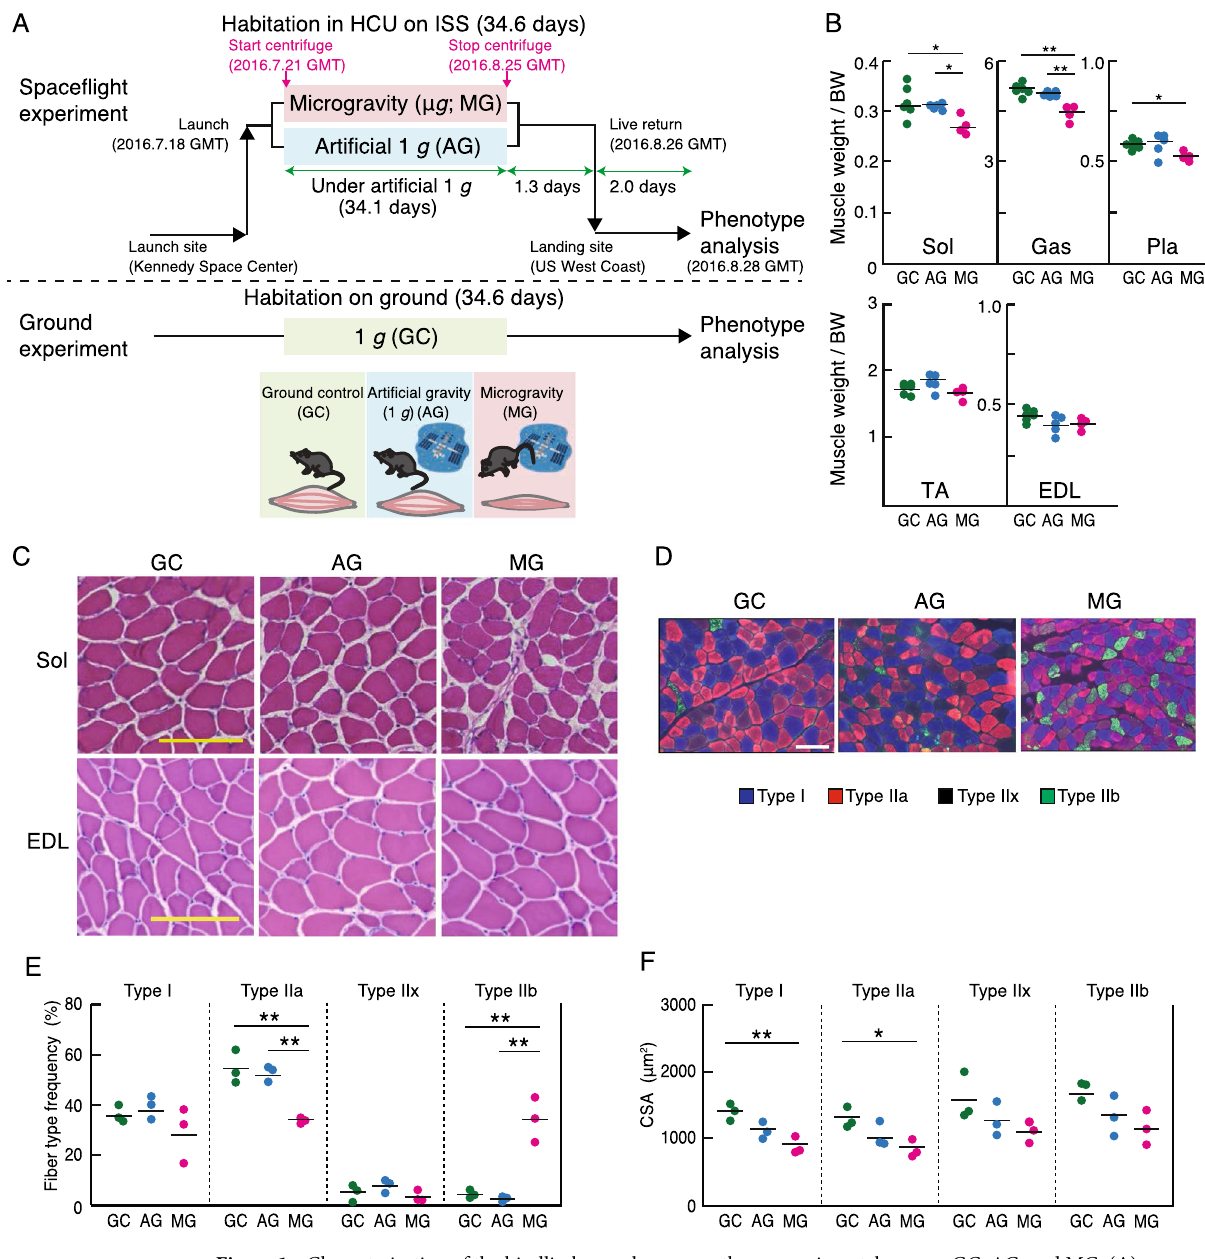
Figure 1. Characterization of the hindlimb muscles among three experimental groups: GC, AG, and MG. ( A ) Overview of the MHU-1 study. Twelve male mice were launched by SpaceX-9 from the Kennedy Space Center in Florida on July 18, 2016. After arrival at the ISS, six of the mice were housed in HCU under microgravity (MG) for approximately 34.6 days, while the other six mice were housed in an artificial 1 g onboard environment (AG) induced by centrifugation for approximately 34.1 days during the approximate 37-day berthing period. After approximately 35 days of habitation on the ISS, all 12 mice were loaded into the Dragon capsule and kept under microgravity for approximately 1.3 days before undocking. The capsule subsequently splashed down in the Pacific Ocean near Southern California on August 26, 2016. The mice were then transported to a laboratory for behavioral tests and other analyses after approximately 2 days of undocking. Graphical representations of the study design using the multiple artificial-gravity research system (MARS). Three experimental groups, namely, ground control (GC), artificial 1 g onboard environment (AG), and microgravity (MG) in the ISS, are color-coded as green, blue, and red, respectively, in the following bar graphs. ( B ) Quantification of the change in individual skeletal muscle weights: soleus (Sol), gastrocnemius (Gas), plantaris (Pla), tibialis anterior (TA), and extensor digitorum longus (EDL), among GC (n = 6), AG (n = 5), and MG (n = 4) groups, normalized by body weight and graphed in the Tukey boxplot. P -value from Tukey’s test is indicated as follows: * P < 0.05 and ** P < 0.01. ( C ) Hematoxylin–eosin staining of soleus and EDL sections. Scale bars indicate 100 μm. ( D ) Immunostaining of the myosin heavy chain using muscle fiber-specific antibodies (type I; blue, type IIa; red, type IIb; green) in the soleus muscle. The unstained fibers were predicted to be of type IIx fibers (black). Scale bars indicate 100 μm. ( E , F ) Frequency ( E ) and cross-sectional areas (CSA) ( F ) of each fiber type in the soleus muscles of the GC (n = 3), AG (n = 3), and MG (n = 3). P -value from Student’s t -test is indicated as follows: * P < 0.05 and ** P <